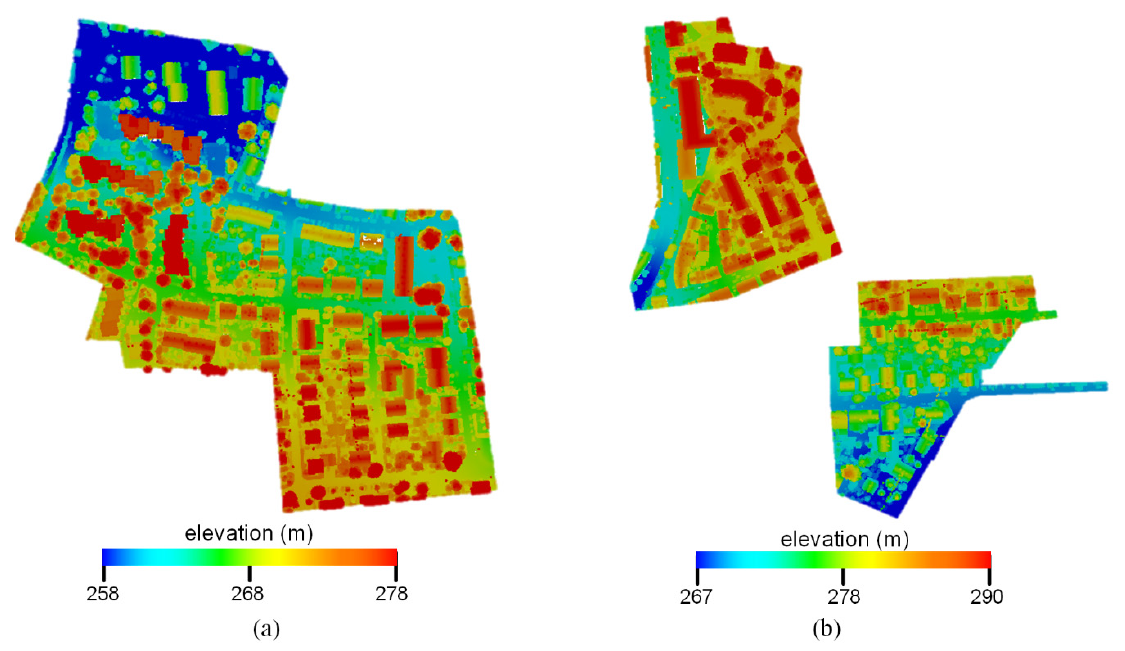
Figure 1. International Society for Photogrammetry and Remote Sensing (ISPRS) benchmark data: ( a ) training data, ( b ) testing